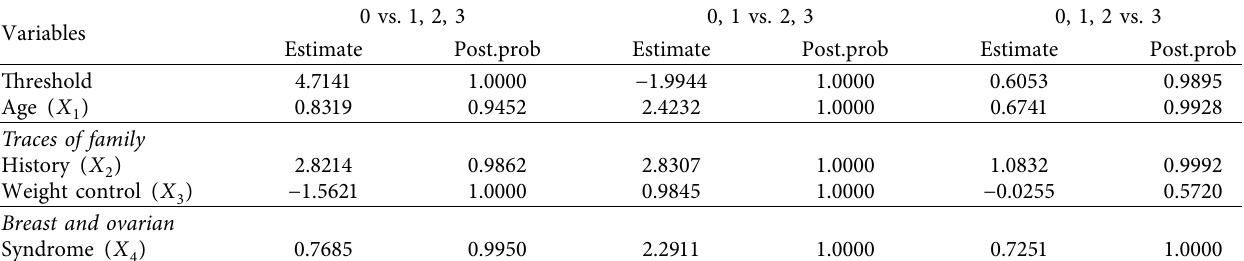
Table 1: Parameter estimates for each outcome of prostate cancer.